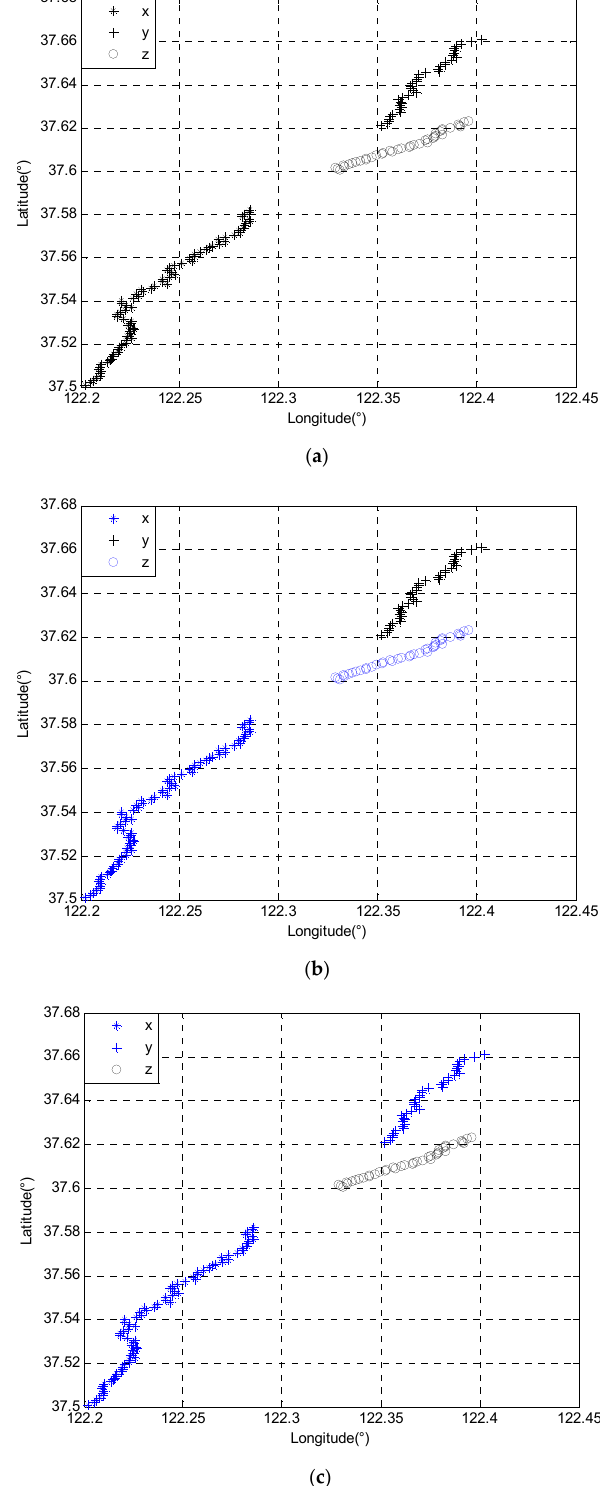
Figure 6. Comparison of track association results: ( a ) track segments from field data; ( b ) association results of the conventional TSA algorithm; ( c ) association results of the proposed method. Table 4. Statistical results of track segment association based on radar data (%).